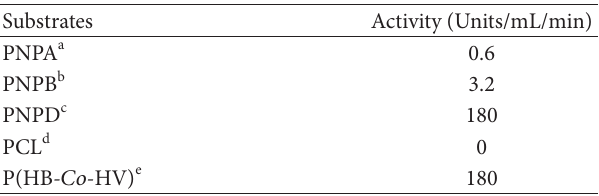
T 3: Substrate speci�cities of F. solani PHB depolymerase on different polymers.